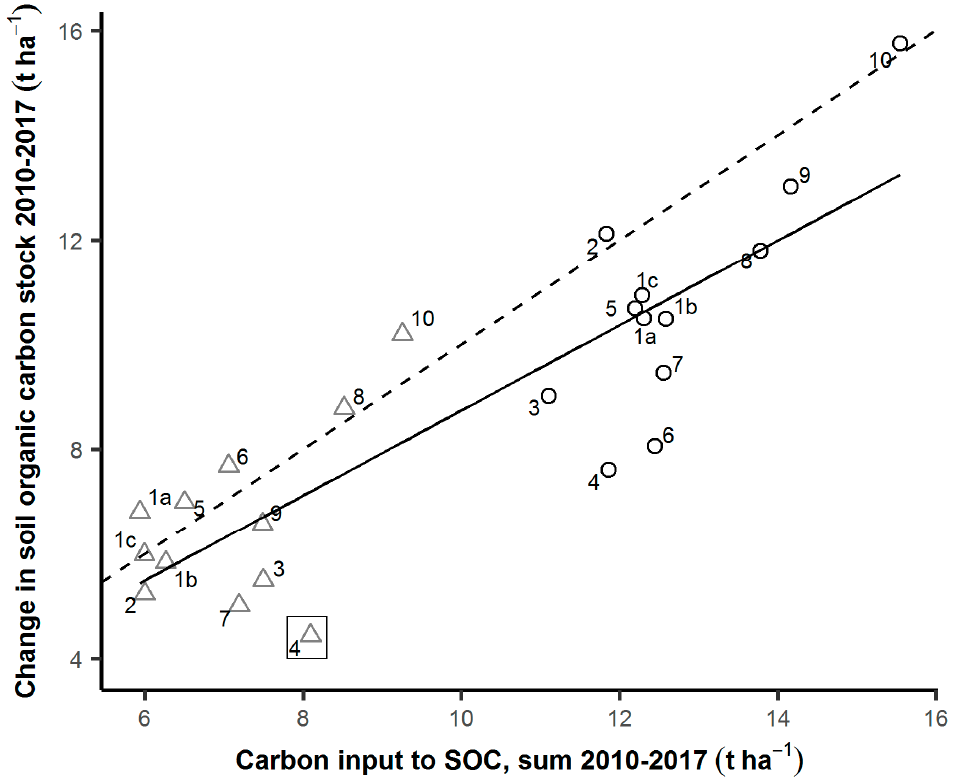
Figure 6. Correlation between estimated total (sum) C input to SOC (t ha − 1 ) for each CR in the period 2010–2017, and the measured change in SOC stock (t ha − 1 ) of that CR between 2010 and 2017 ( n = 24). Each data point is the mean of 16 plots to reduce propagation of uncertainty resulting from the subtraction of the SOC stock in 2010 from the SOC stock in 2017. Unfertilised plots are represented by grey triangles, fertilised plots by black circles. The number next to a data point is the CR. The solid line is the regression line (y = 0.61 + 0.81x, R 2 = 0.74, p < 0.001, n = 24). The dashed line is the 1:1 line. The data point marked with a square is an outlier (CR4 unfertilised plots). Estimated C inputs to SOC varied between 5.9 and 15.5 t ha − 1 depending on the CR 15.8 t ha − 1 . The data indicated that the increase in SOC stocks was, on average, 1.3 t ha − 1